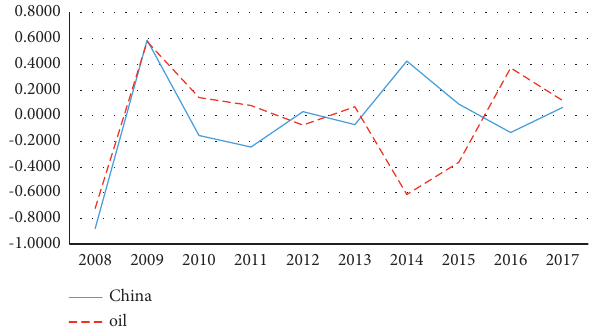
Figure 7: Oil price volatility and China’s Shanghai composite